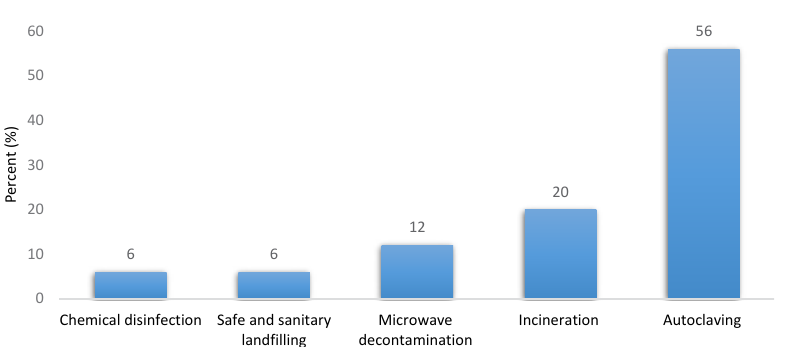
Figure 2. The desirability of the waste decontamination method of decentralized health centers